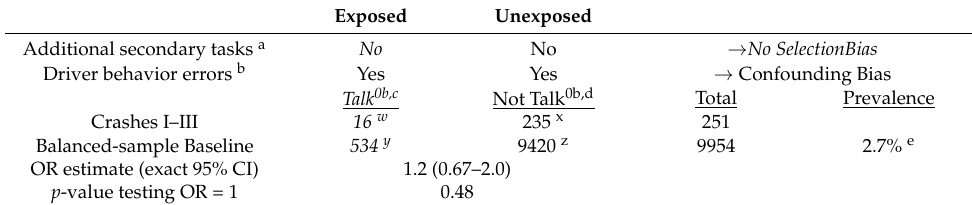
Table 2. Method 1 to remove “additional task” selection bias from Table 1 (Stratum 1 of Table 1).